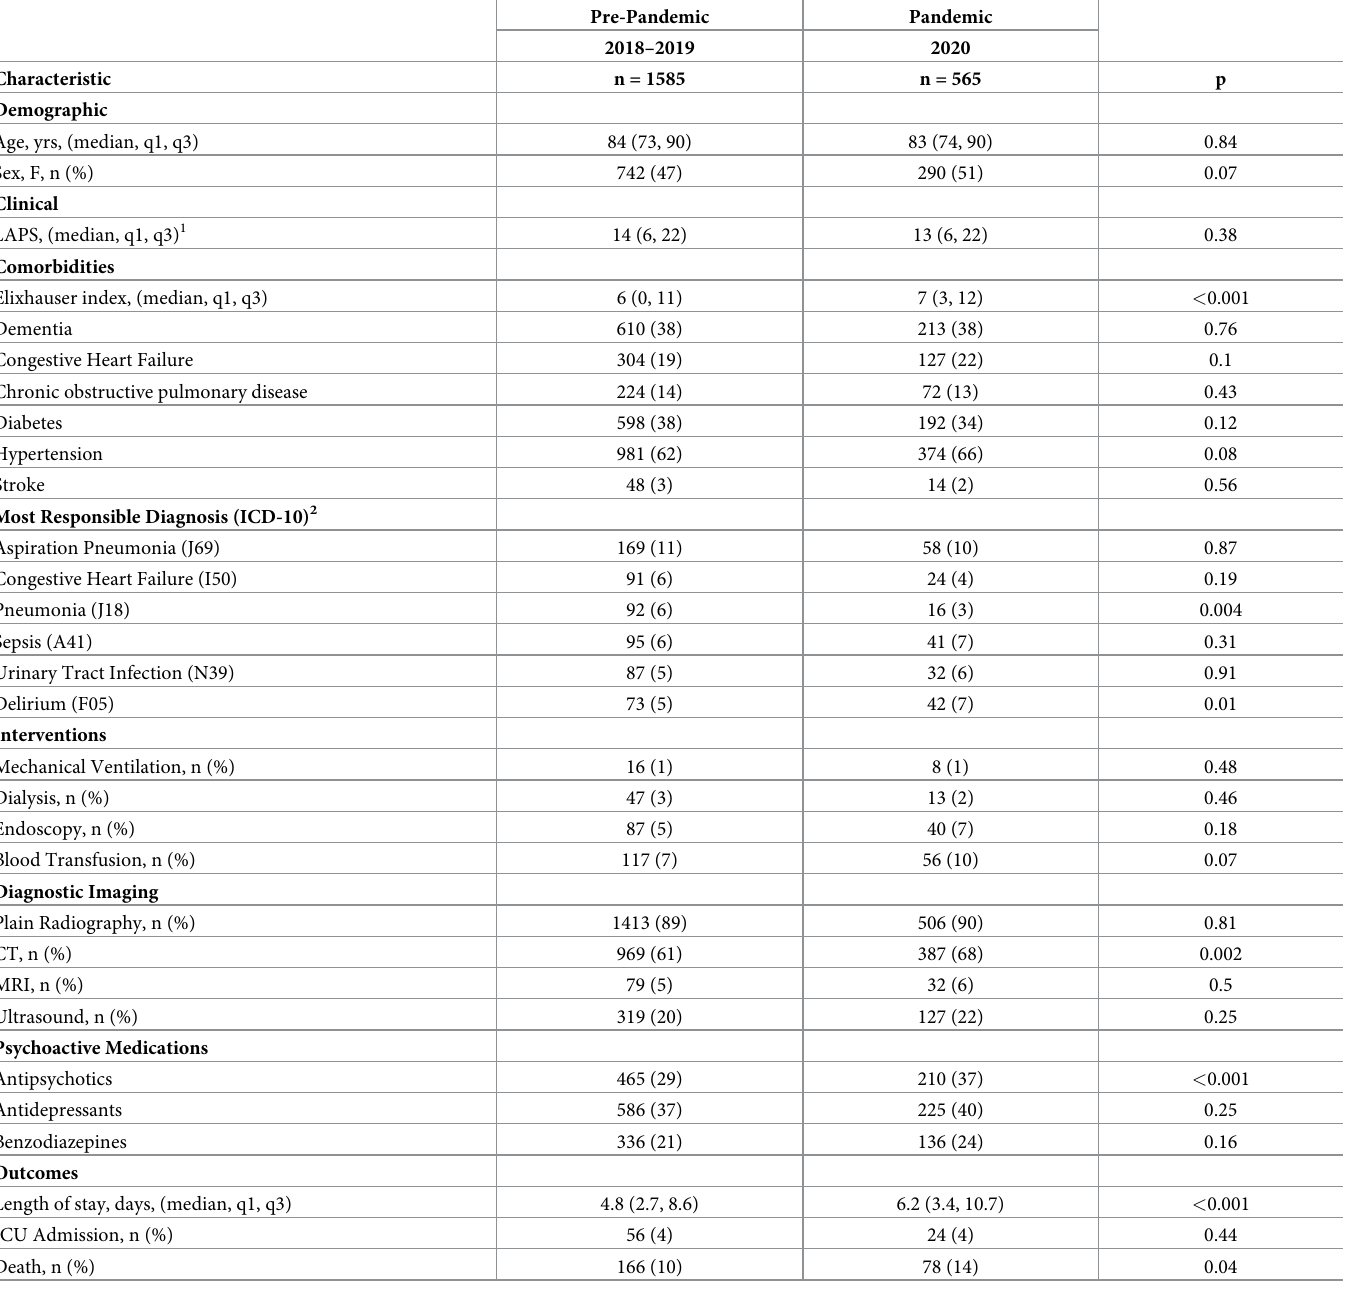
Table 3. Demographic and clinical characteristics, in-hospital care, and outcomes of long-term care residents admitted to general internal medicine wards, March to December,